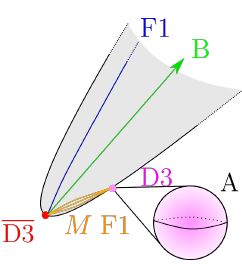
Figure 3 . The bottom of the KS throat in which every point has a finite S 3 attached to it due to the A-cycle. The anti-D3 is pointlike and has M stretched string attached to the D3 wrapping the full A-cycle (which is instead pointlike in 4D.) Those M strings are depicted in orange. We also consider strings that start at the anti-D3 and leave the throat to end somewhere on a D7 in the bulk. Such an example string is depicted in